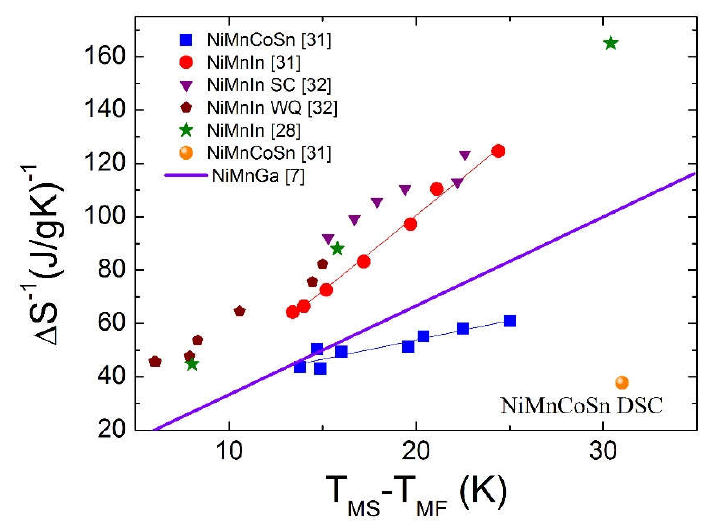
Figure 4. The reciprocal values of entropy change during MT measured for metamagnetic alloys (symbols). Theoretical values obtained for Ni-Mn-Ga alloy system are presented for comparison by the solid line. Thin lines are guides for the eye [7,28,31,32].